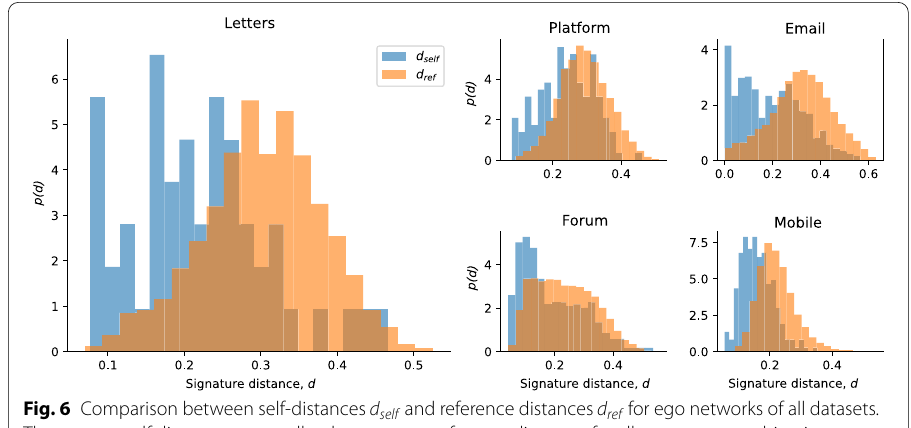
Fig. 6 Comparison between self‑distances d self and reference distances d ref for ego networks of all datasets. The average self distances are smaller than average reference distances for all parameter combinations, implying that social signatures tend to be more similar for the same person during different times, than to other people’s signatures. We performed a two‑sided T‑test for difference in means, finding that for all datasets the mean d self differed from d ref with all estimated p values < 10 − 13 . The estimated means for all datasets are: Letters ˆ d self = 0.218 ± 0.048 and ˆ d ref = 0.302 ± 0.008 ; Platform ˆ d self = 0.241 ± 0.025 and ˆ